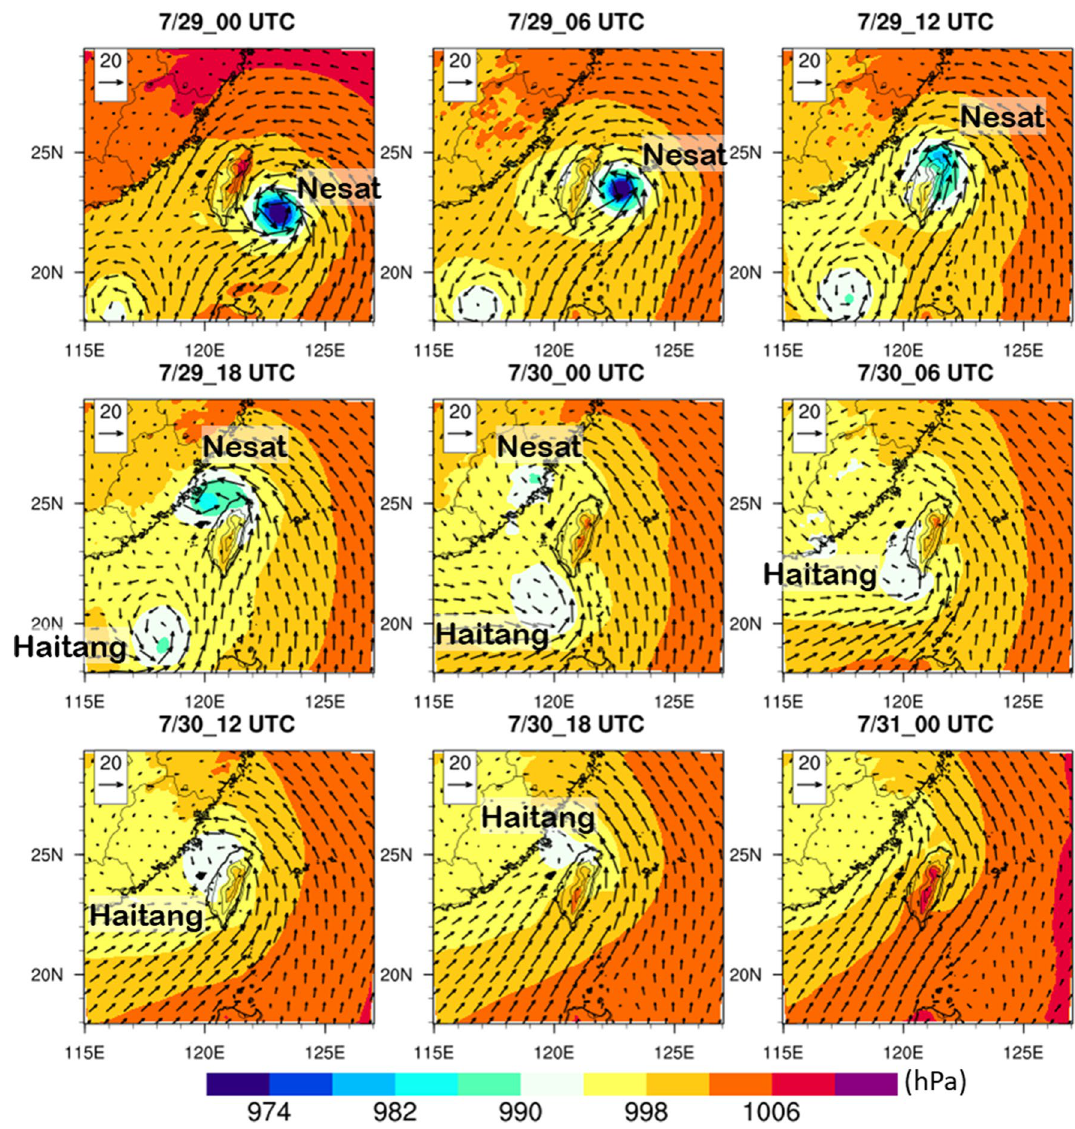
Figure 2. Sea level pressure (shaded, hPa) and 10-m horizontal wind (vector, m s −1 ) in the WRF model domain 1 (resolution is 6 km) during 29–31 July, 2017. Maps and plots were produced using NCAR Command Language (NCL) version 6.6.2 37